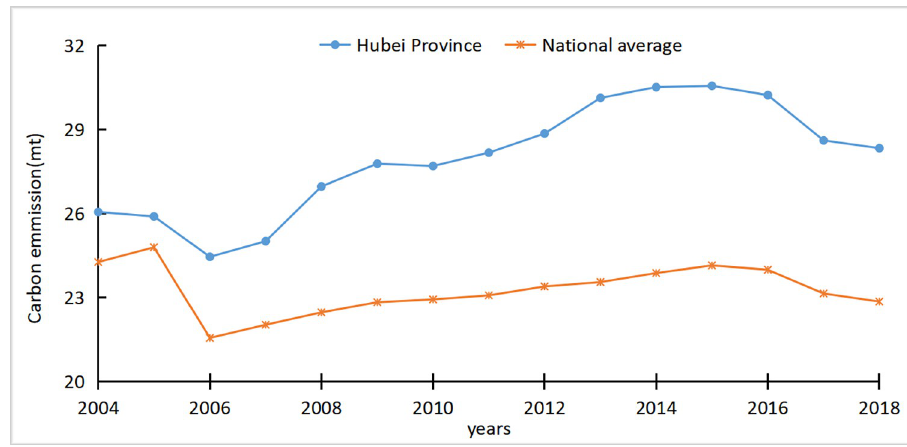
Fig 1. Hubei Province and national average agricultural carbon emission measurement